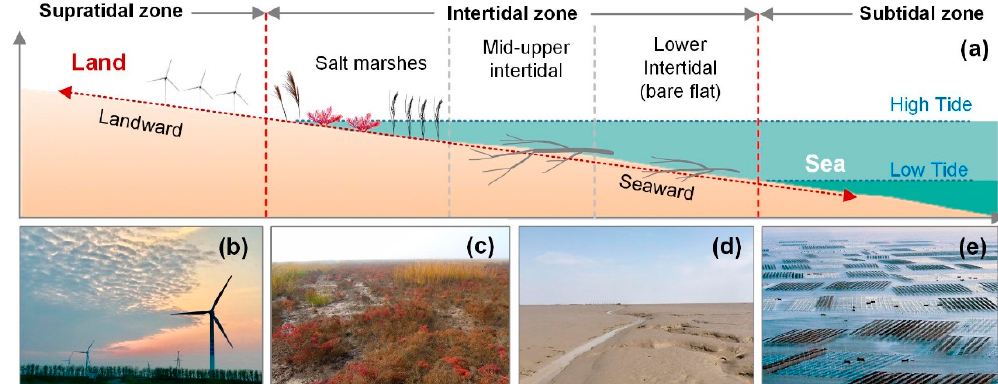
Figure 2. E-W zonation of tidal flats from land to sea. The two red dashed lines delineate the extent of the study area. ( b – e ) Coastal wind farm, salt marsh vegetation (Reeds, Suaeda maritima , and Spartina alterniflora ), tidal creeks and laver cultivation zone